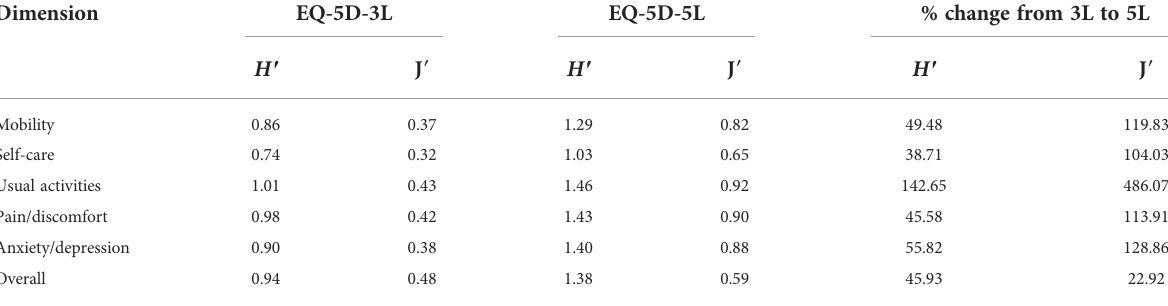
TABLE 4 Shannon index (H ′ ) and Shannon Evenness index (J ′ ) for the 3L and 5L. Dimension